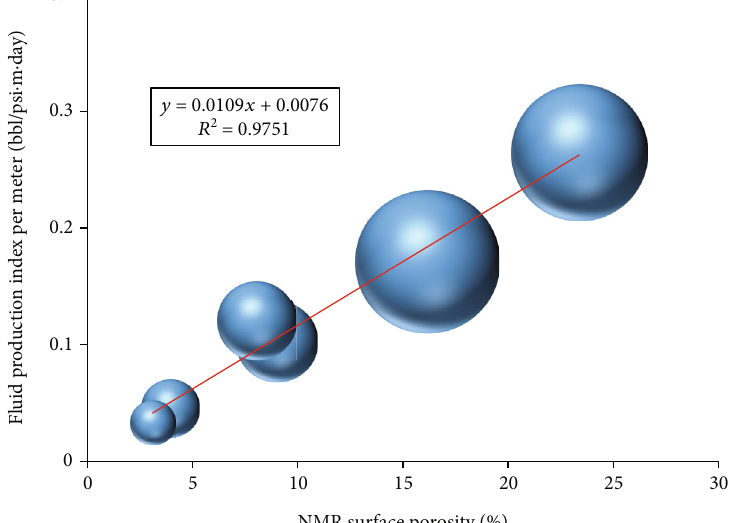
Figure 10: Intersection diagram of NMR secondary porosity and fl uid production index per meter in production layer X3.